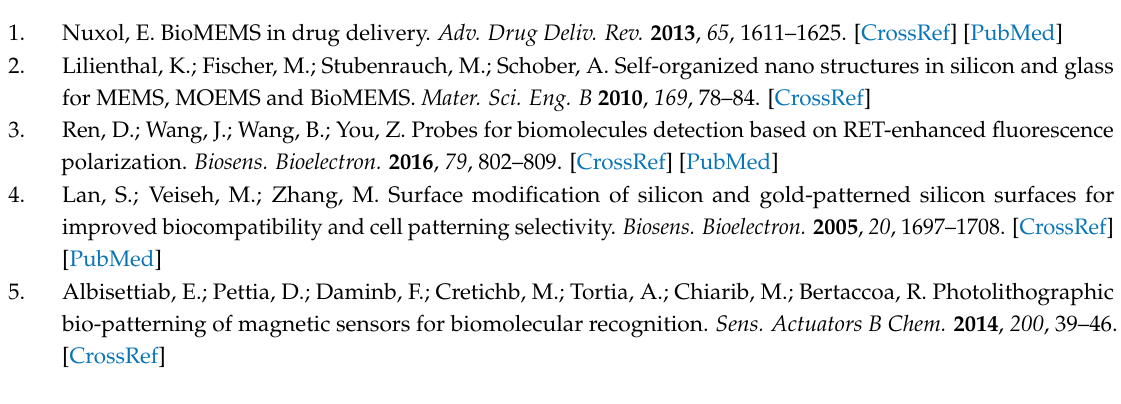
Figure S1: Adhesion of proteins on the substrates. Table S1: T-test of the Influence of the heating time on the surface contact angle. Figure S2: Observation of CD15 expressions. Figure S3: Observation of the immunocapture of HL-60 cells based on CD45 antigens. Figure S4: Cells coverage under the cell concentration of 5 × 106 cells/mL. Figure S5: Ratio of the live cells after 10